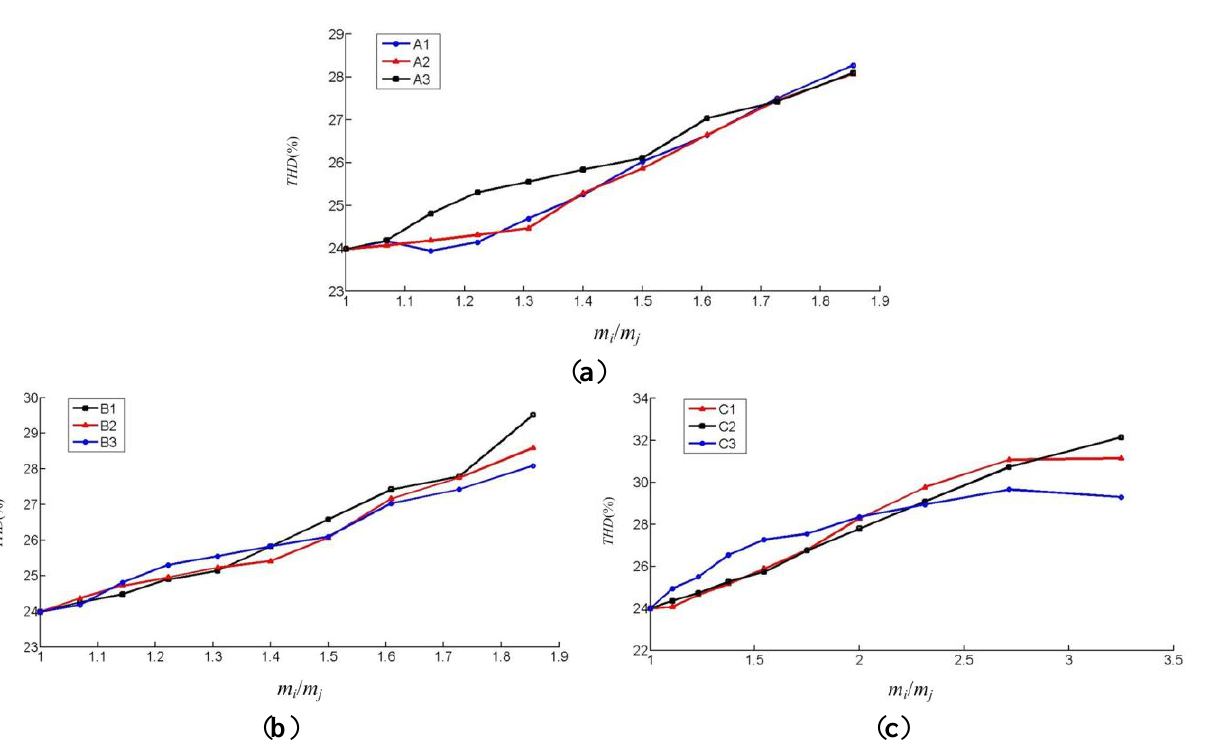
Figure 3. Curves of total harmonic distortion of output voltage. ( a ) Under situation of m i / m j ; ( b ) Under situation opposite to ( a ); ( c ) Under situation of m i / m j and the